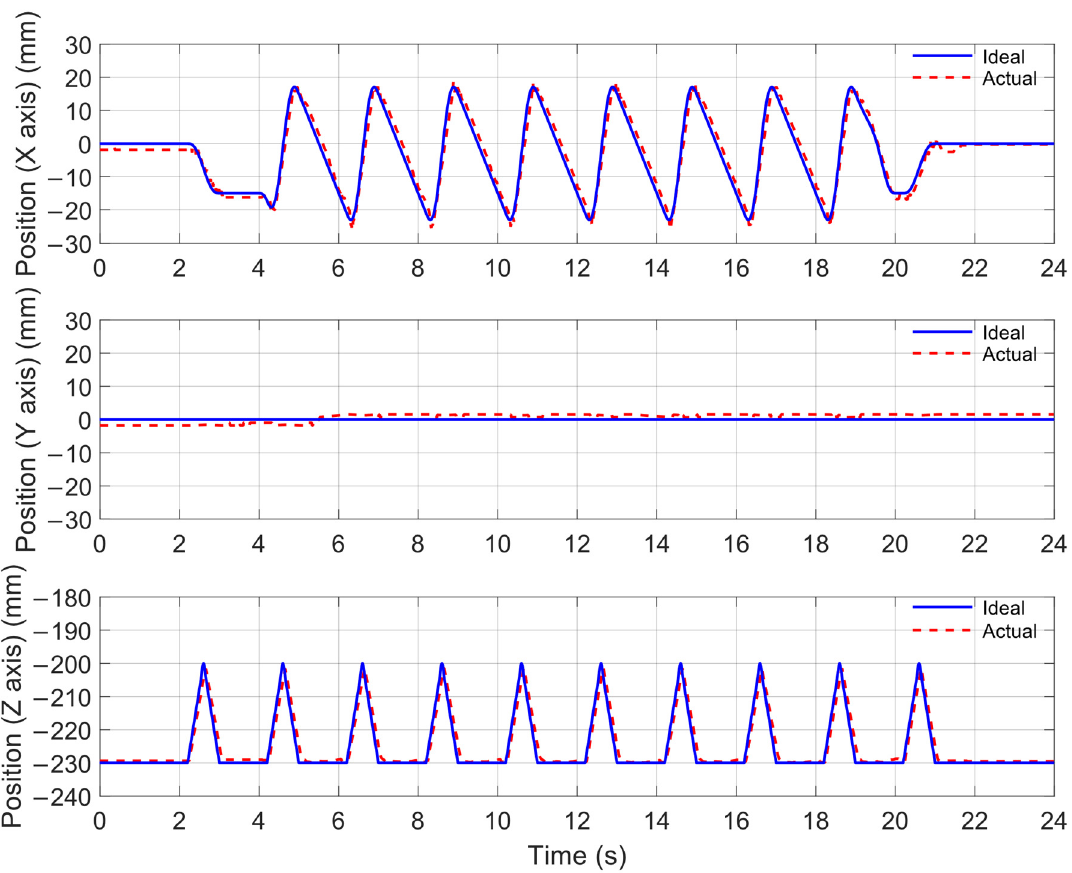
Figure 13. Comparison between the ideal foot trajectory and the actual foot trajectory of leg 1 in tripod gait.